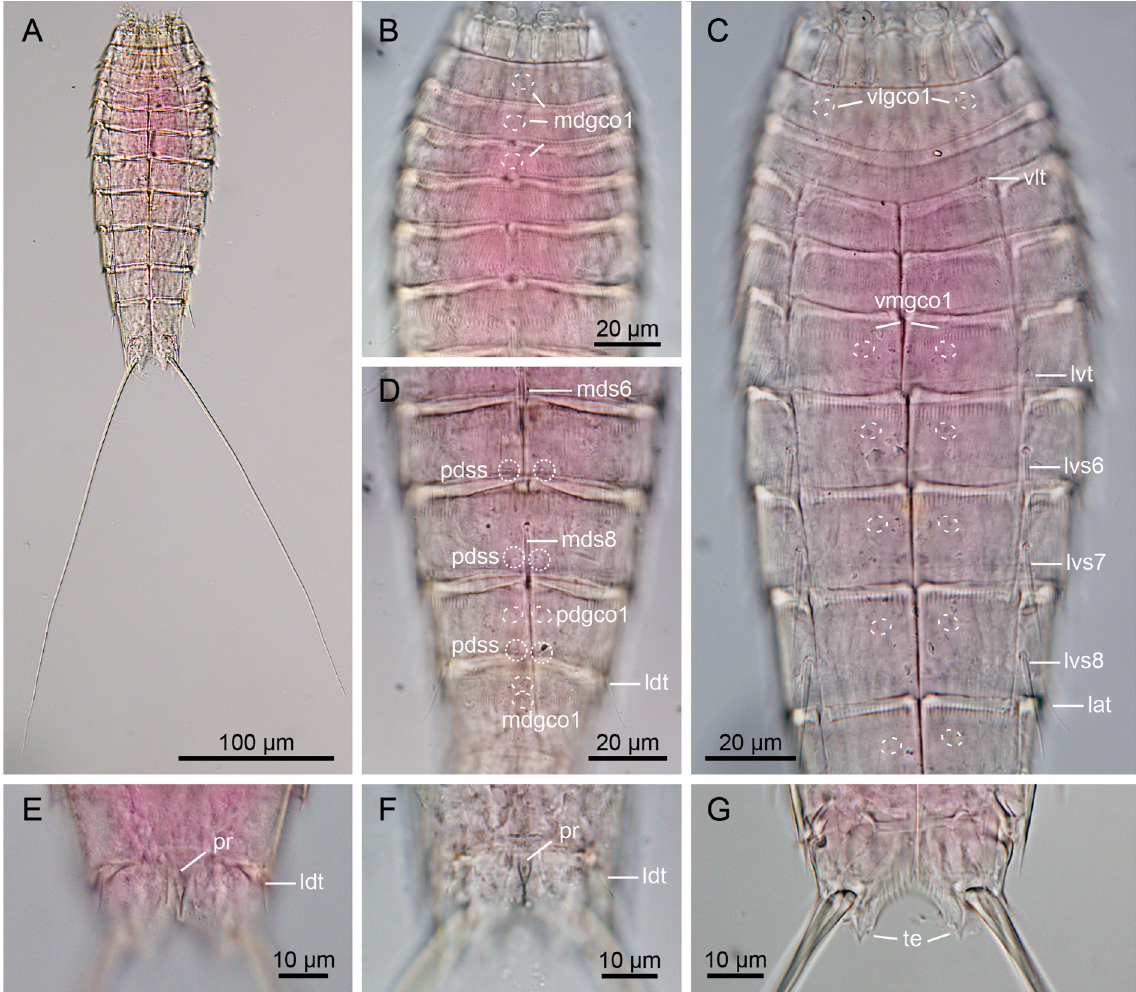
Fig. 15. Light micrographs showing overview and details of Echinoderes gandalfi sp. nov. A–D, F . ♂, holotype (NIWA-159407). E, G . ♀, paratype (NHMD-916362). A . Ventral overview. B . Segments 1 to 6, dorsal view. C . Segments 1 to 9, ventral view. D . Segments 6 to 10, dorsal view. E . Segments 10 to 11 of female, dorsal view. F . Segments 10 to 11 of male, dorsal view. G . Segment 11 of female, ventral view. Abbreviations: see Material